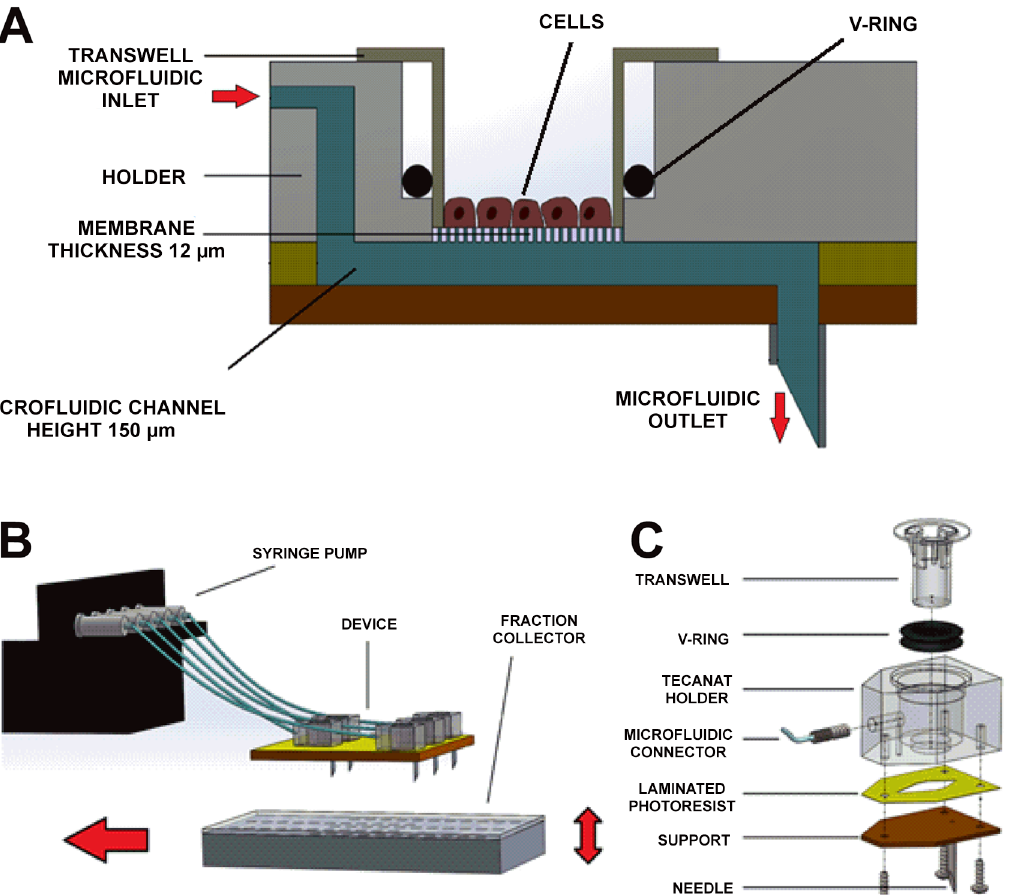
Fig 1. Design and assembly of the microfluidic culture system. a: Schematic section of a culture well: cells are cultured on a Transwell 1 inserted in the holder. A V-ring is used to seal the system. b: Schematic of the setup: each well is connected to the syringe pump. A plate is placed under the device and is moved to allow for the time-resolved fraction collection. c: Exploded view of the assembly of a single well. Five layers of dry film photoresist are laminated on top of a support layer. A holder is screwed on top of the support layer and a Transwell 1 is subsequently inserted together with the V-ring. The microfluidic inlet is screwed in the holder while the outlet needle is glued on the bottom of the support layer.